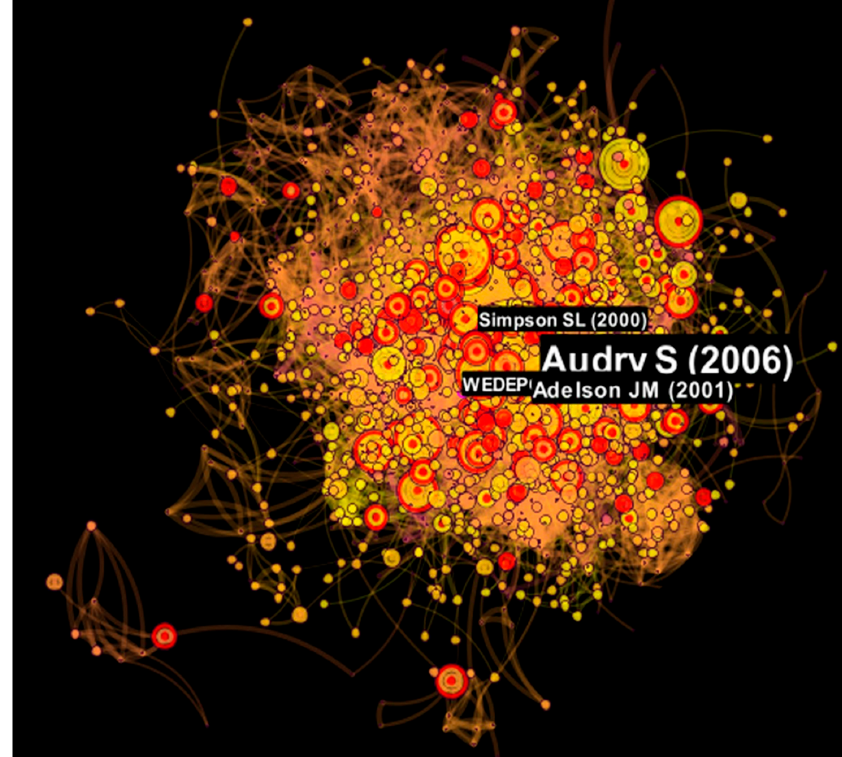
Figure 4. The top article citations in studies related to the impacts of climate change on heavy metal contamination in coastal areas, based on the Web of Science Core Collection database (1979–2021).